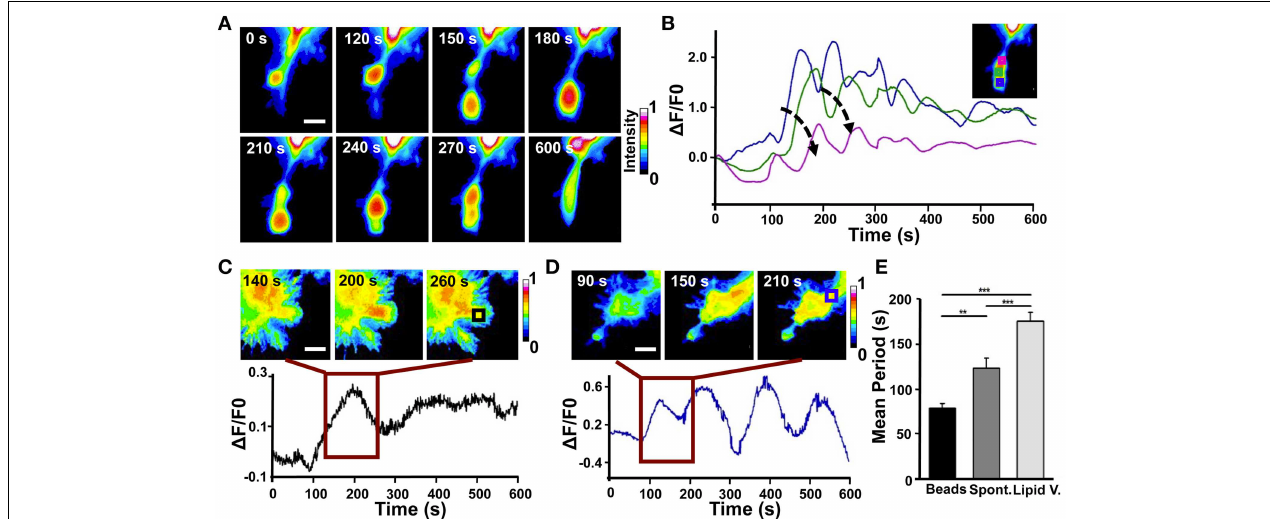
a black square in the image at the top right. (D) Top: Time series (1 frame every 60s) of the Cdc42 wave behavior during spontaneous motion for the time defined by the dark red square in the bottom plot. Bottom: Plot of average Cdc42 activity ( 1 F / F 0 ) in the region defined as a blue square in the image at the top right. (E) Quantification of the period of the oscillations both during spontaneous motion and upon local stimulation. Mean period ± SEM of 10 periods from 3 experiments for bead stimulation, 10 periods from 2 experiments for spontaneous motion and 10 periods from 3 experiments for lipid vesicles stimulation. ** p < 0 . 01 , *** p < 0 . 01 using ANOVA test. Scalebars in (A,C,D) : 10 µ